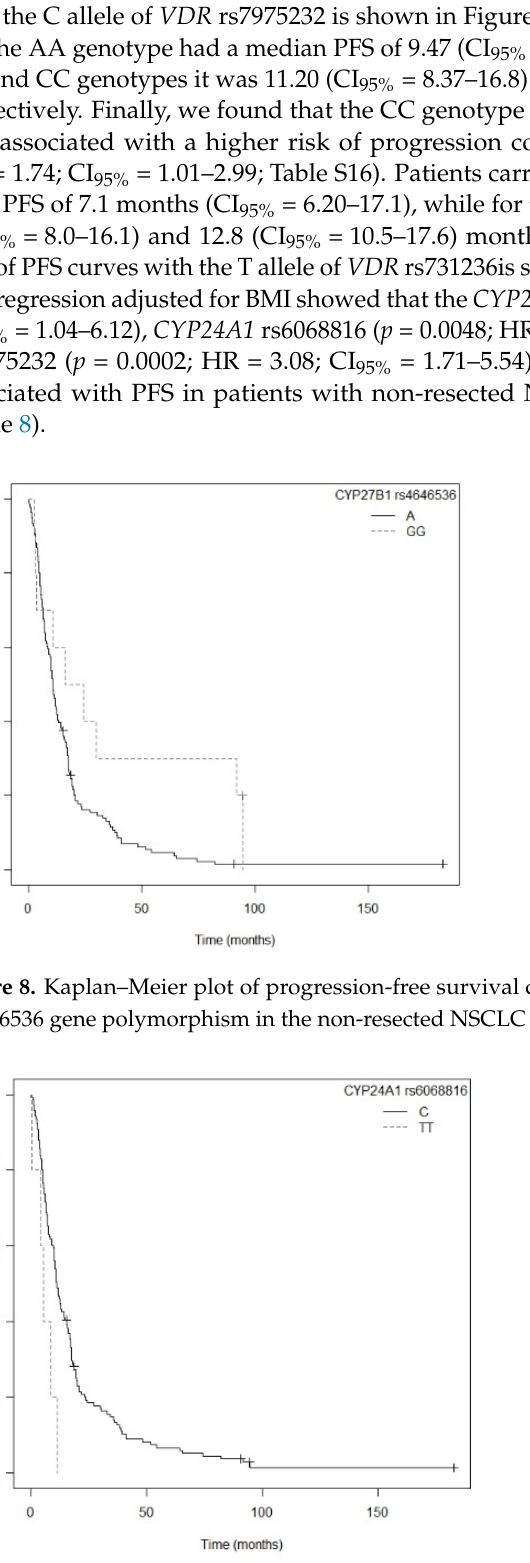
Figure 10. Kaplan–Meier plot of progression-free survival curves with the C allele of the VDR rs7975232 gene polymorphism in the non-resected NSCLC subgroup. Table 8. Influence of gene polymorphisms and clinical characteristic on progression-free survival of non-resected NSCLC patients.